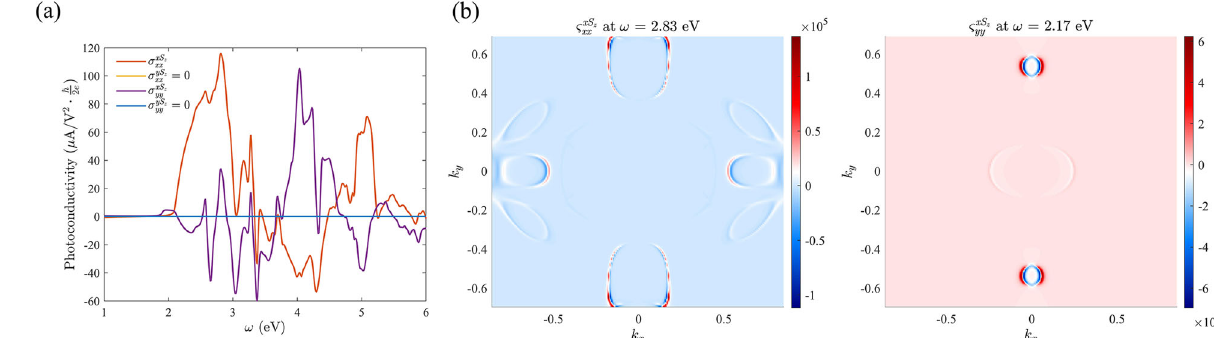
Fig. 3 BSPV response of monolayer GeS. a BSPV photoconductivity component of monolayer GeS under LPL. b Momentum space ω ¼ 2 : 83eV ; k Þ and ς x ; S z ω ¼ 2 : 17eV ; k Þ distributions of the integrand ς x ; S z xx ð yy ð